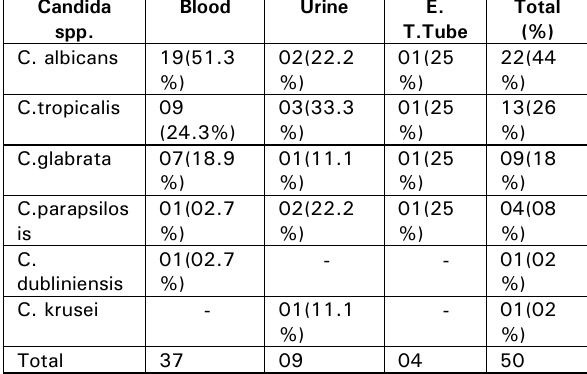
Table No 5: Distribution of Candida spp. From various clinical